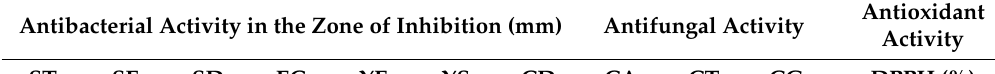
Table 1. Antibacterial activity of SP-AuNPs, SP-AgNPs, and SP extract against Gram-negative and Gram-positive pathogenic bacteria of livestock and free radical scavenging activity of the synthesized AuNPs and AgNPs as calculated using the DPPH assay. For the antimicrobial test, 20 µ L volume of each NP suspension was prepared from 5 mg · mL − 1 of stock concentration; for the antioxidant assay, 10 − 1 –10 − 5 dilution was prepared from 5 mg · mL − 1 of stock